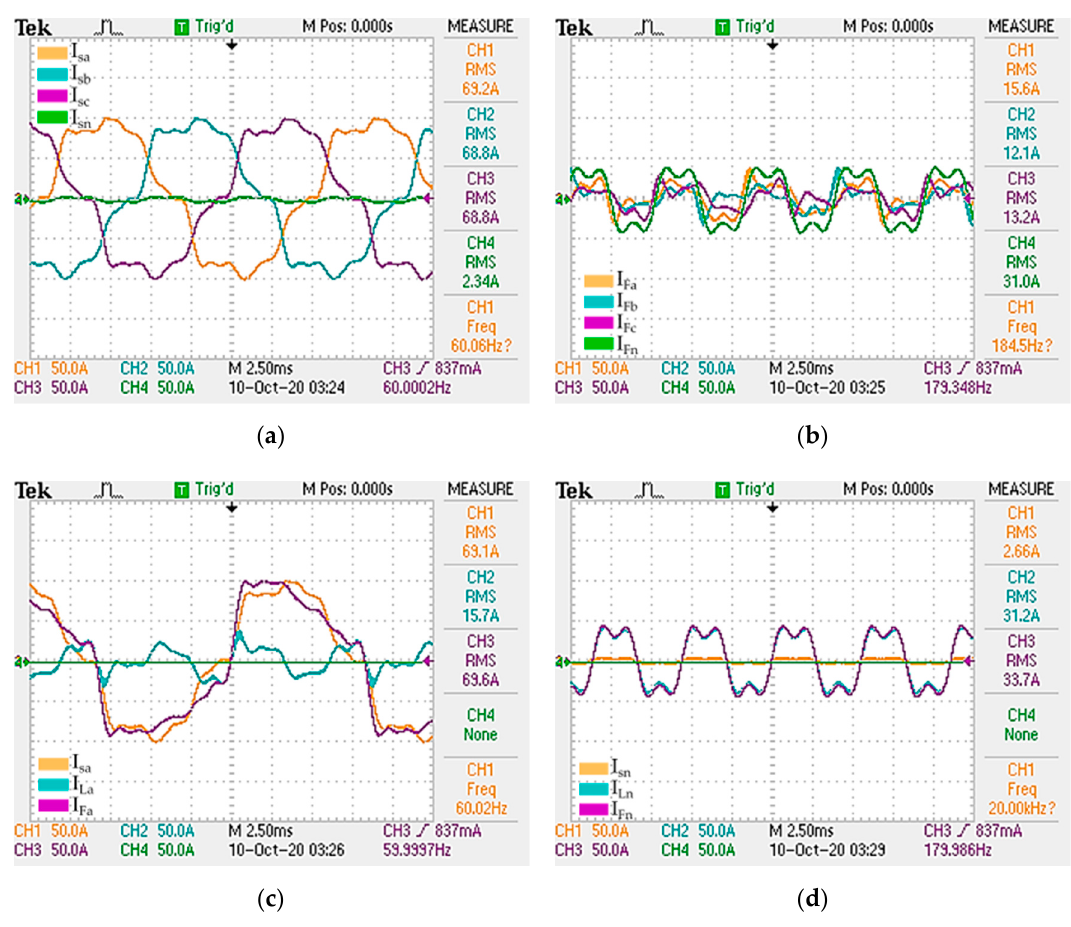
Figure 12. ES3 scenario. ( a ) 3-phase and neutral source current. ( b ) Output Filter Current. ( c ) Source, load and output filter phase-a current. ( d ) source, load and output filter neutral current. Current scale is configured to 50 A/div and time scale is configured to 2.50 ms.